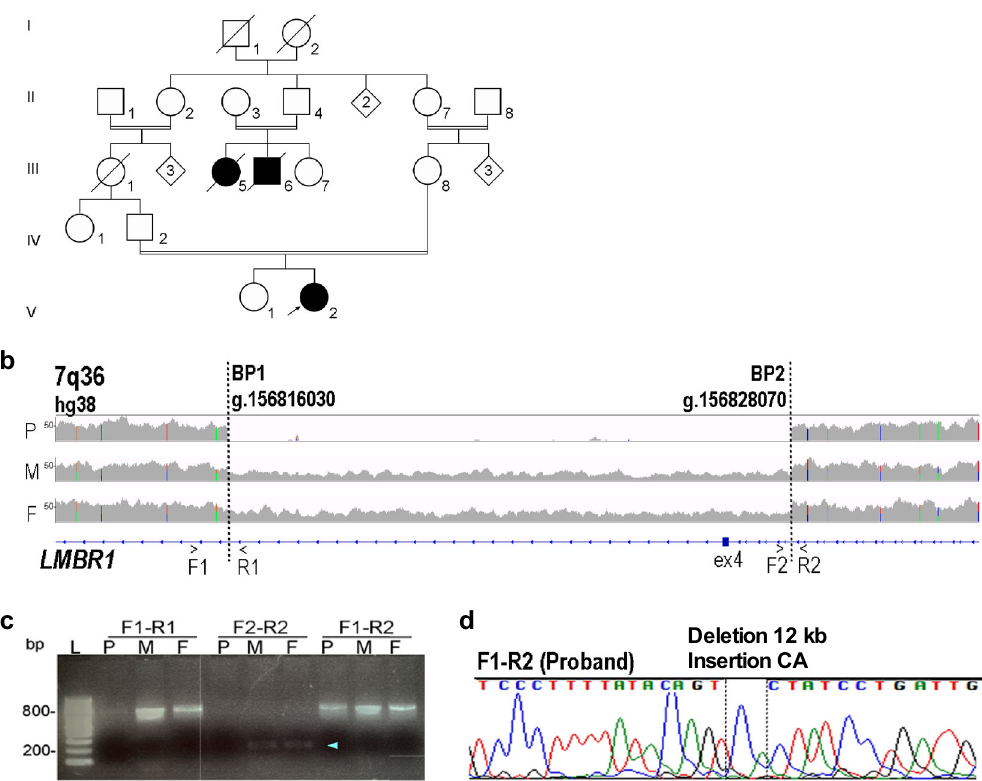
Fig. 1 Fine-mapping of the acheiropodia-associated deletion. a Pedigree of acheiropodia family with proband indicated via the arrow. Squares and circles represent males and females, respectively. b WGS alignments showing a homozygous 12 kb deletion in the acheiropodia proband. The Y-axis is the read depth (number of reads for each nucleotide). The deletion appears in a heterozygous manner in both parents. BP: breakpoint; P: proband; M: mother; F: father. c PCR ampli fi cation using three different primers pairs, whose location is indicated in b , further con fi rming the breakpoint in the proband (P) and mother (M) and father (F). PCR was performed several times using different primer sets to validate the deletion. d Sanger sequencing of the acheiropodia patient showing the breakpoint sequence which also has a CA insertion.